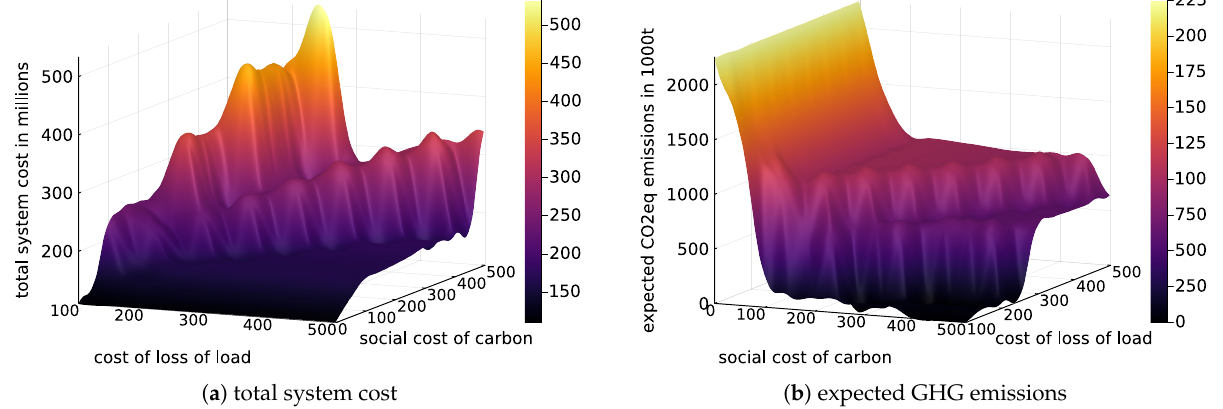
Figure 8. ( a ) shows the total system cost in millions of $US with respect to both the valuation of GHG emissions and unserviced load demand. ( b ) analogously shows the CO 2 eq emissions. Note that the axes of ( a , b ) are flipped for better